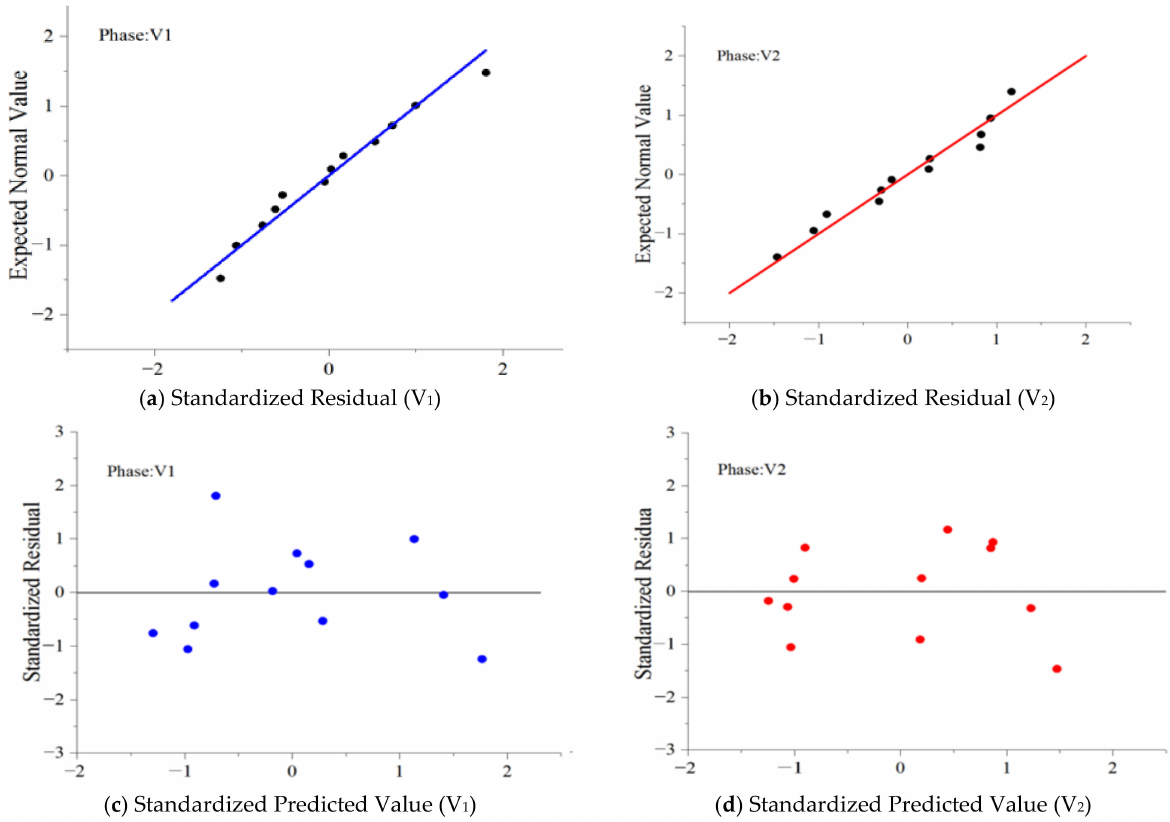
Figure 10. Normal Q-Q plot and scatterplot of regression standardized residual of